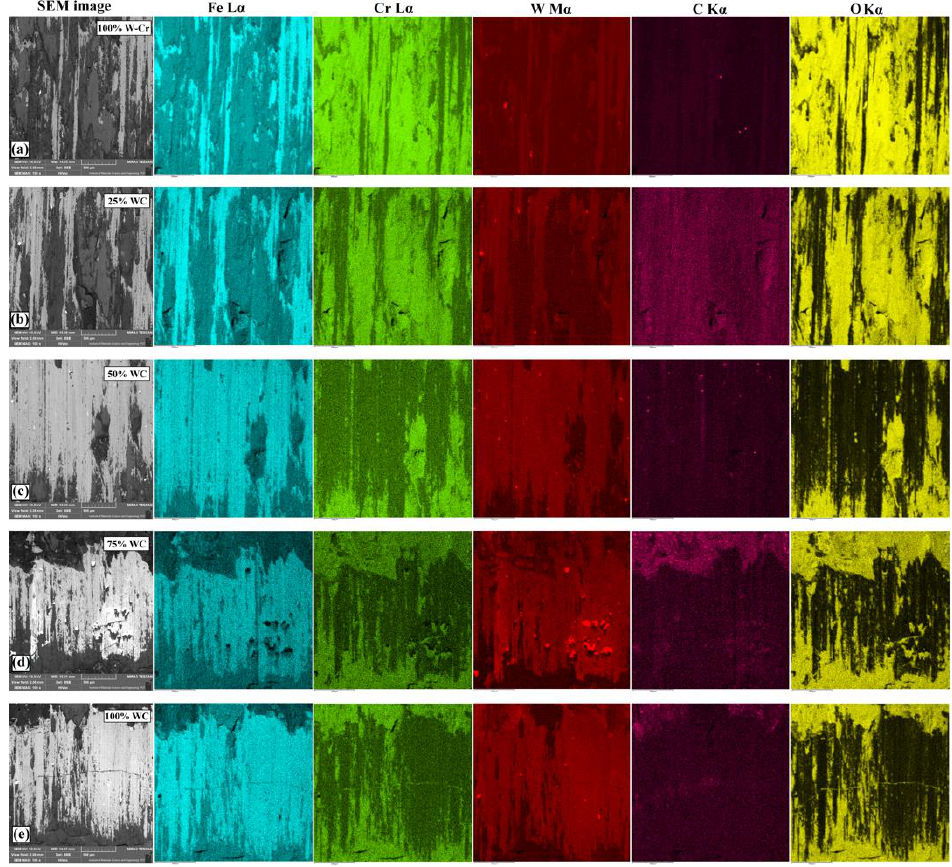
Figure 16. Macroscopic images of the surface condition after wear resistance tests and EDS mapping for the following coatings: ( a ) W–Cr; ( b ) W–Cr / 25% WC; ( c ) W–Cr / 50% WC; ( d ) W–Cr / 75% WC; ( e ) 100% WC .